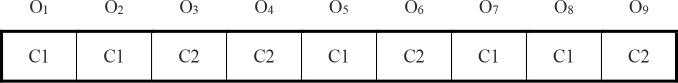
Example of a candidate solution represented by a label-based representation.